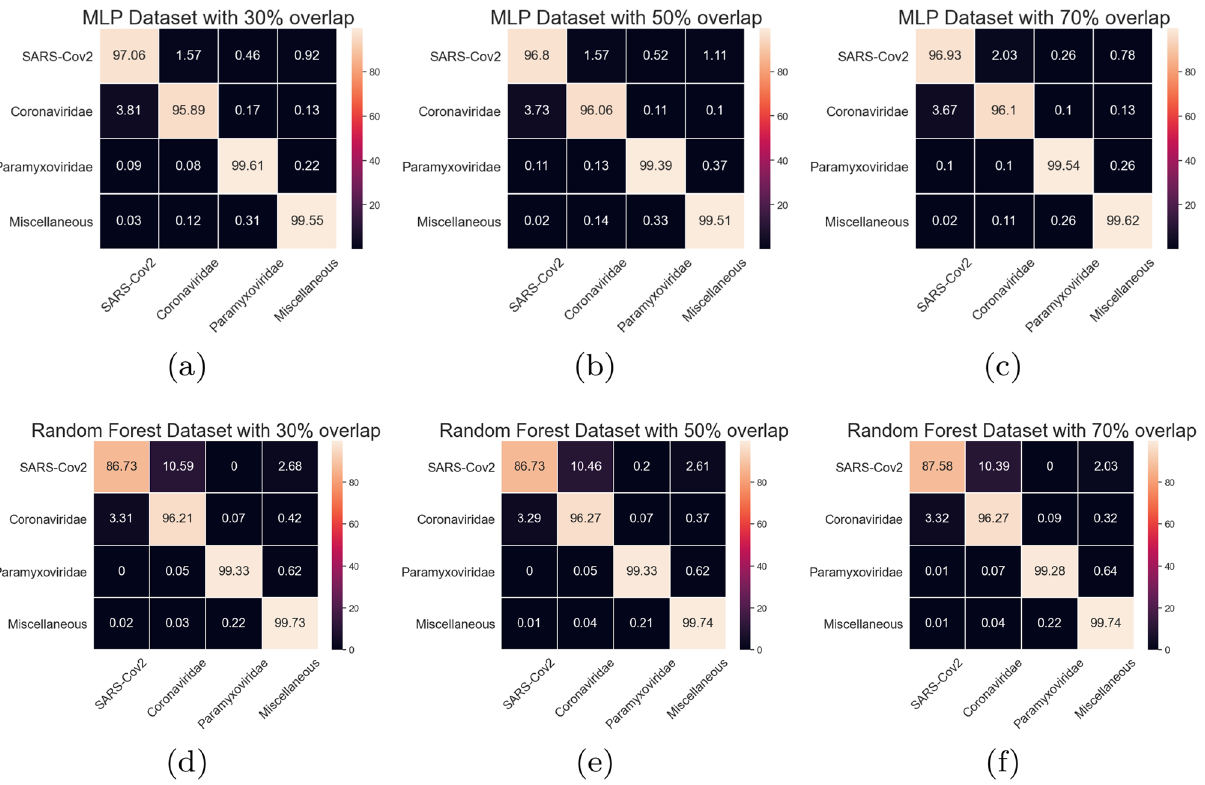
Figure 15. Average Confusion matrices for MLP and Random Forest in the Similar symptoms viruses test scenario.